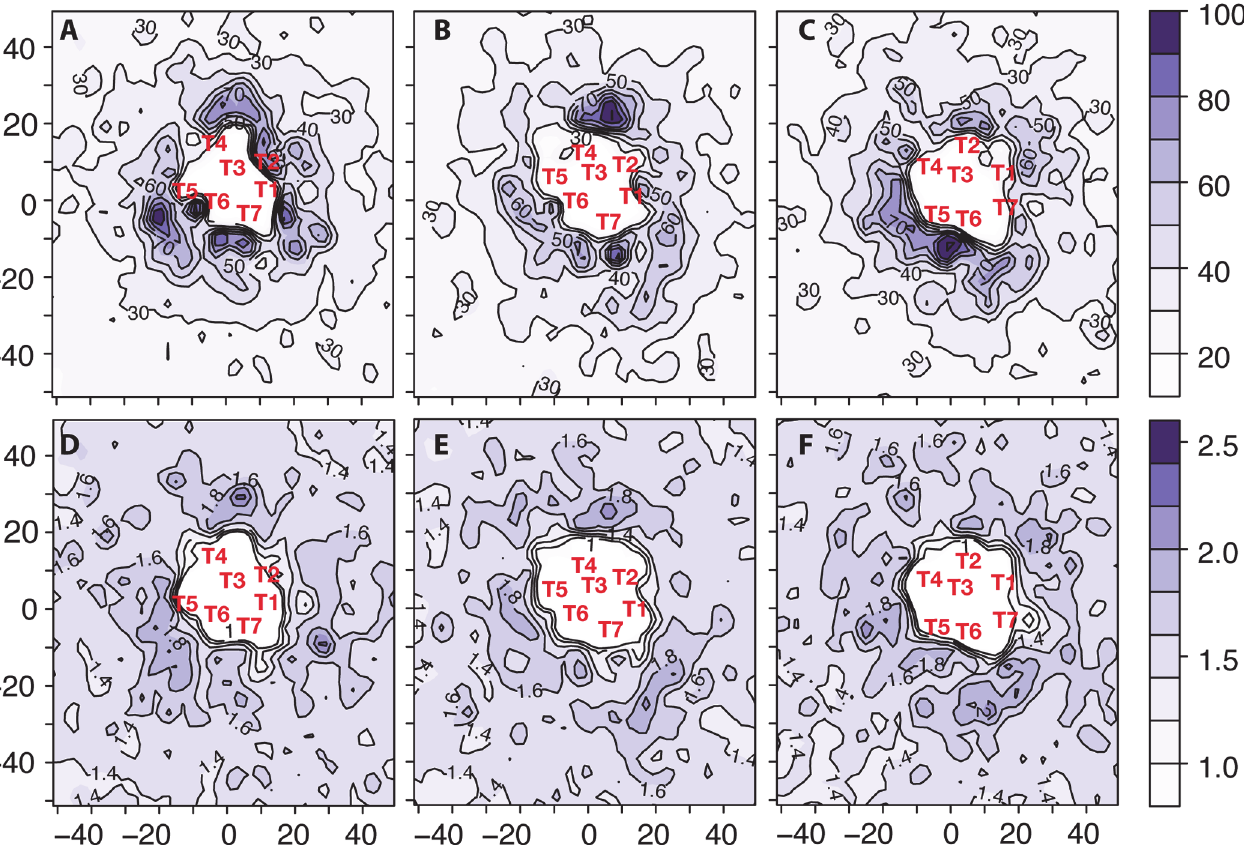
Fig 6. Persistence times and persistence-to-exchange time ratios of cholesterol molecules derived from the OR homo-dimer simulations. Specifically, persistence times of cholesterol calculated for δ -OR/ δ -OR, κ -OR/ κ -OR, and μ -OR/ μ -OR are reported, in ns, in panels A, B, and C, respectively. Persistence-to-exchange time ratios of cholesterol around isolated δ -OR, κ -OR, and μ -OR are shown in panels D, E, and F, respectively. Approximate locations of the centers of mass of the seven transmembrane helices (TM1-TM7) are indicated with red